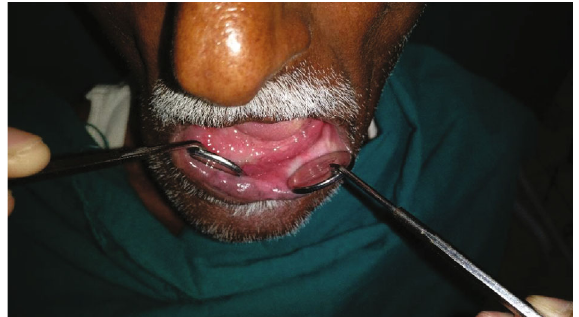
Figure 2: Intraoral view presop.